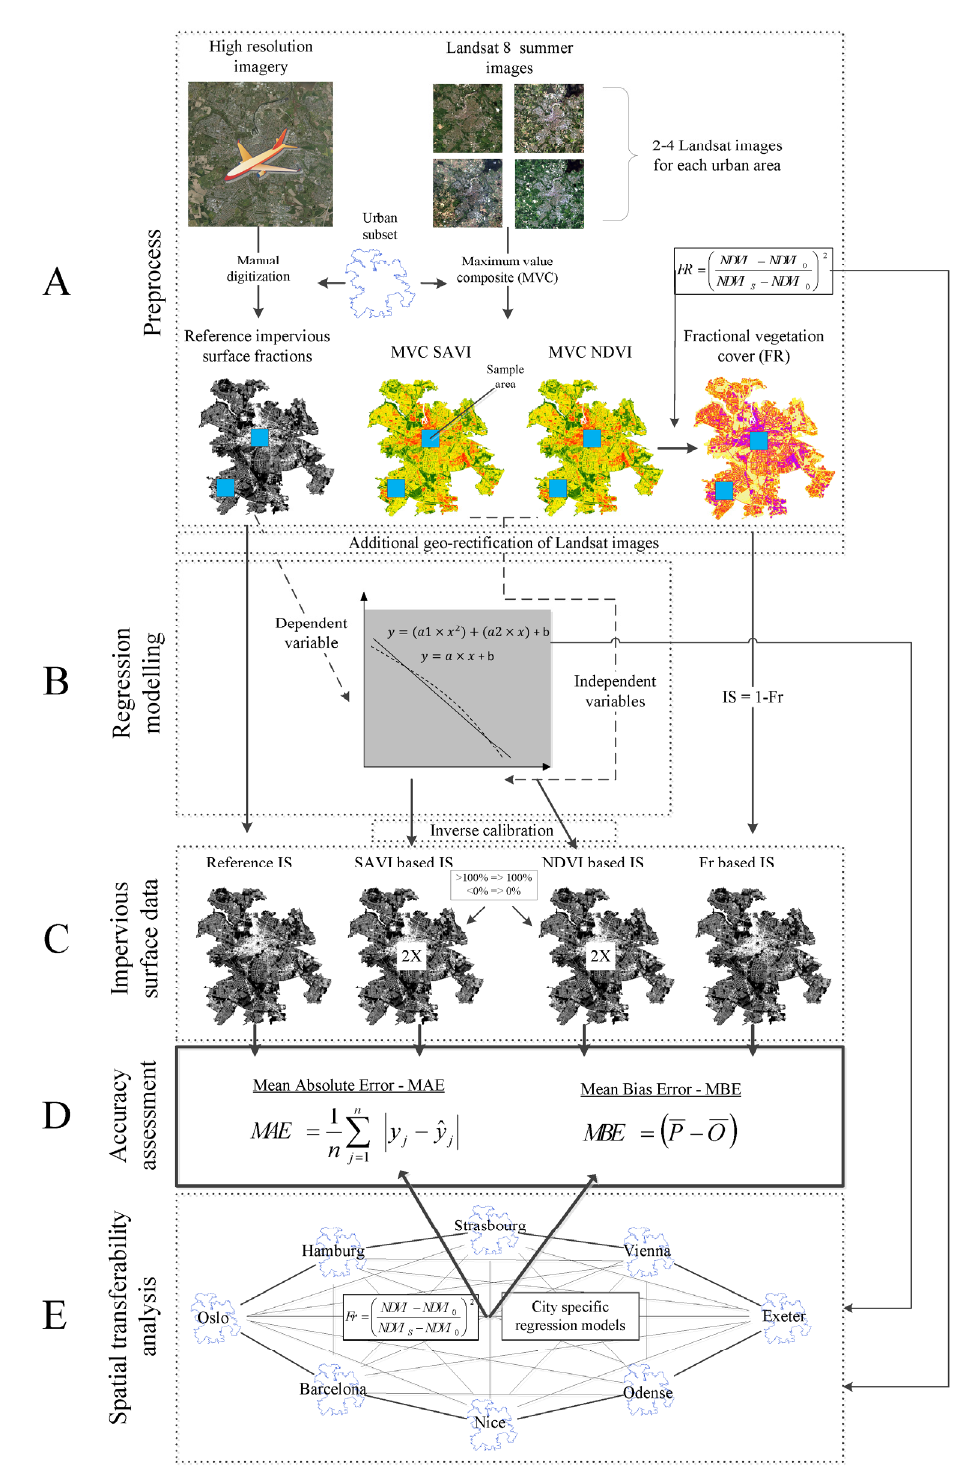
Figure 3. Flowchart of image processing and analyses procedures. ( A ) Preprocess, ( B ) Regression modelling, ( C ) Impervious surface data, ( D ) Accuracy assessment, ( E ) Spatial transferability